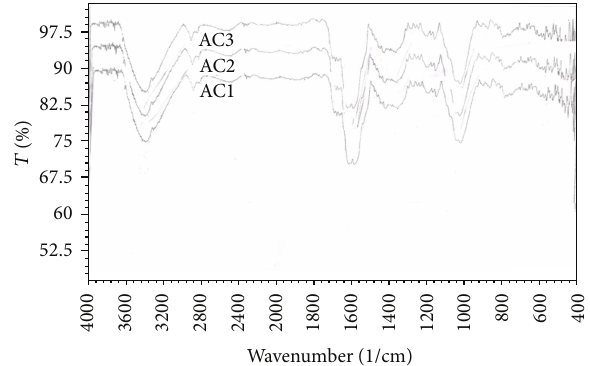
Figure 8: FTIR spectra for AC1, AC2, and AC3 samples synthesized from